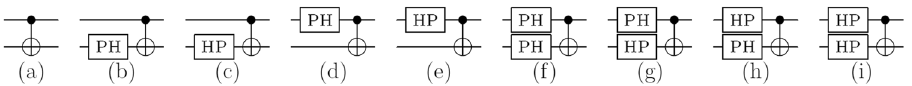
pairs of qubits of a Clifford group 2